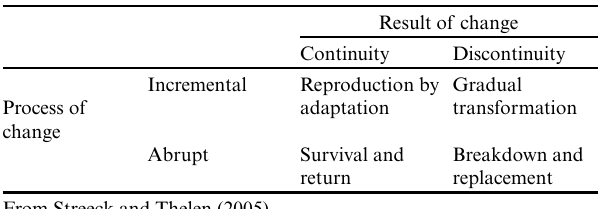
Table 2 . The process and result of change